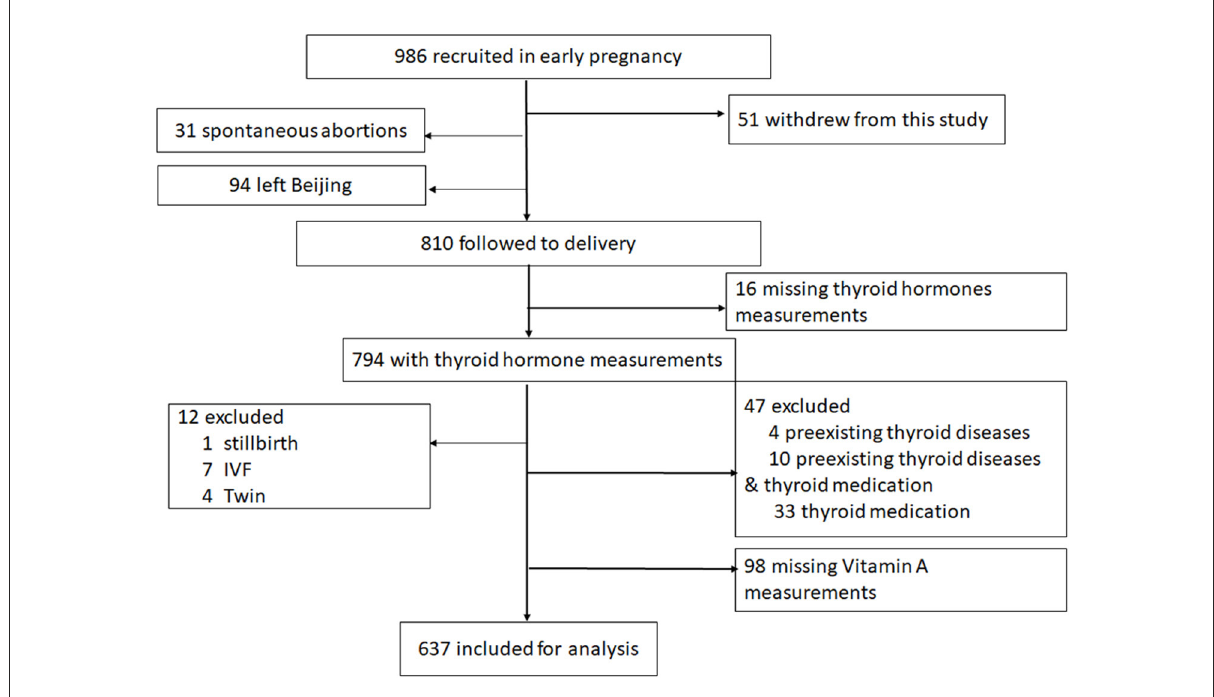
FIGURE1 Flow diagram of study